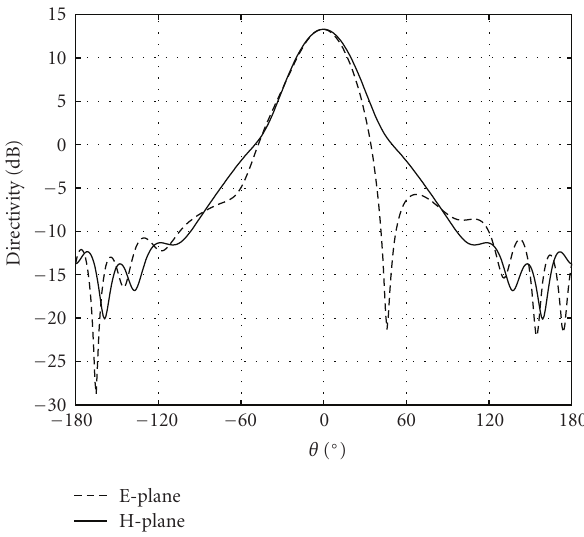
Figure 9: Radiation patterns at the central frequency (5GHz) of the operating bandwidth in the E- and